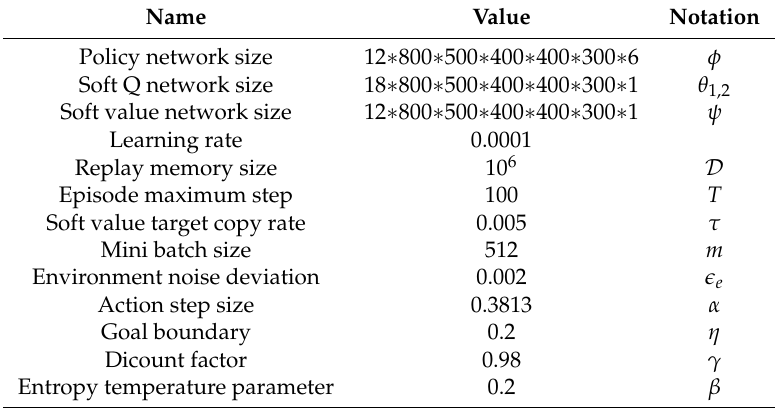
Table 2. Tuning parameters for the designed SAC with HER.